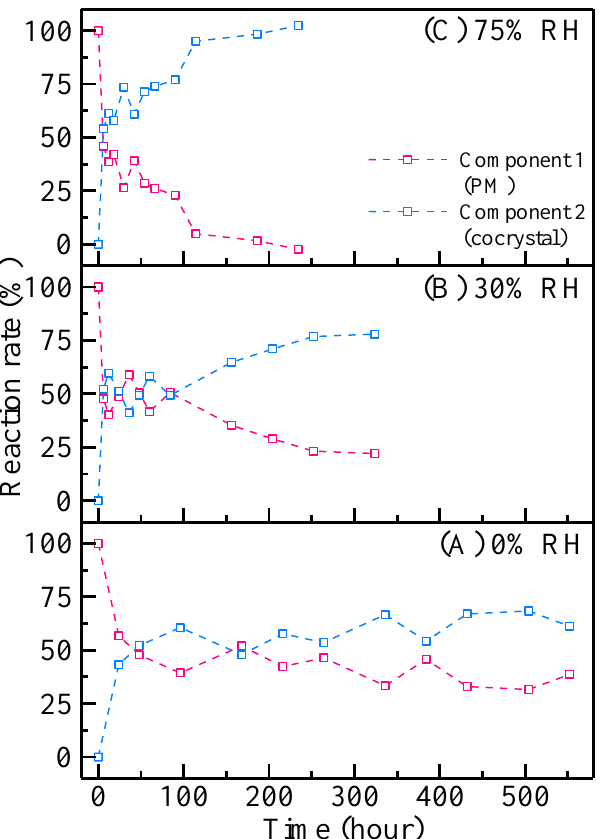
Figure 7. Reaction rates calculated based on THz spectra. Red and blue lines represent the PM (component 1) and cocrystal (component 2), respectively. ( A – C ) represent data collected under 0%, 30% and 75% RH, respectively.